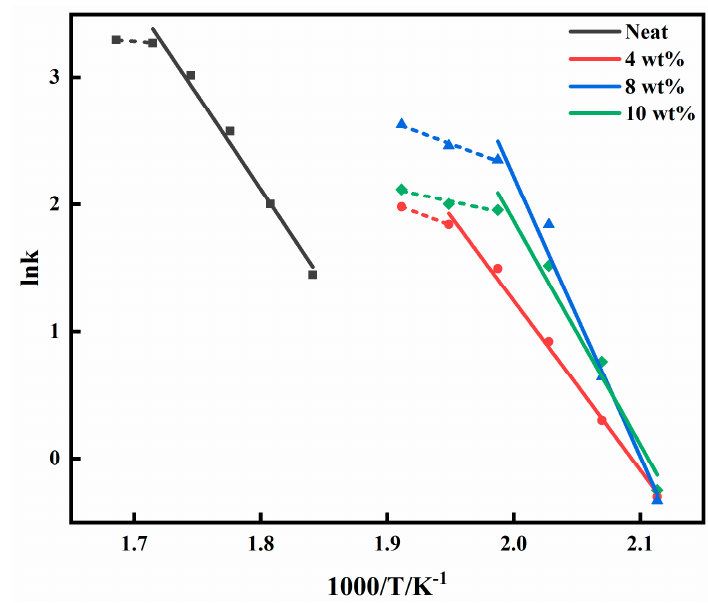
Figure 11. Temperature dependence of the rate constants for the different BADCy systems.